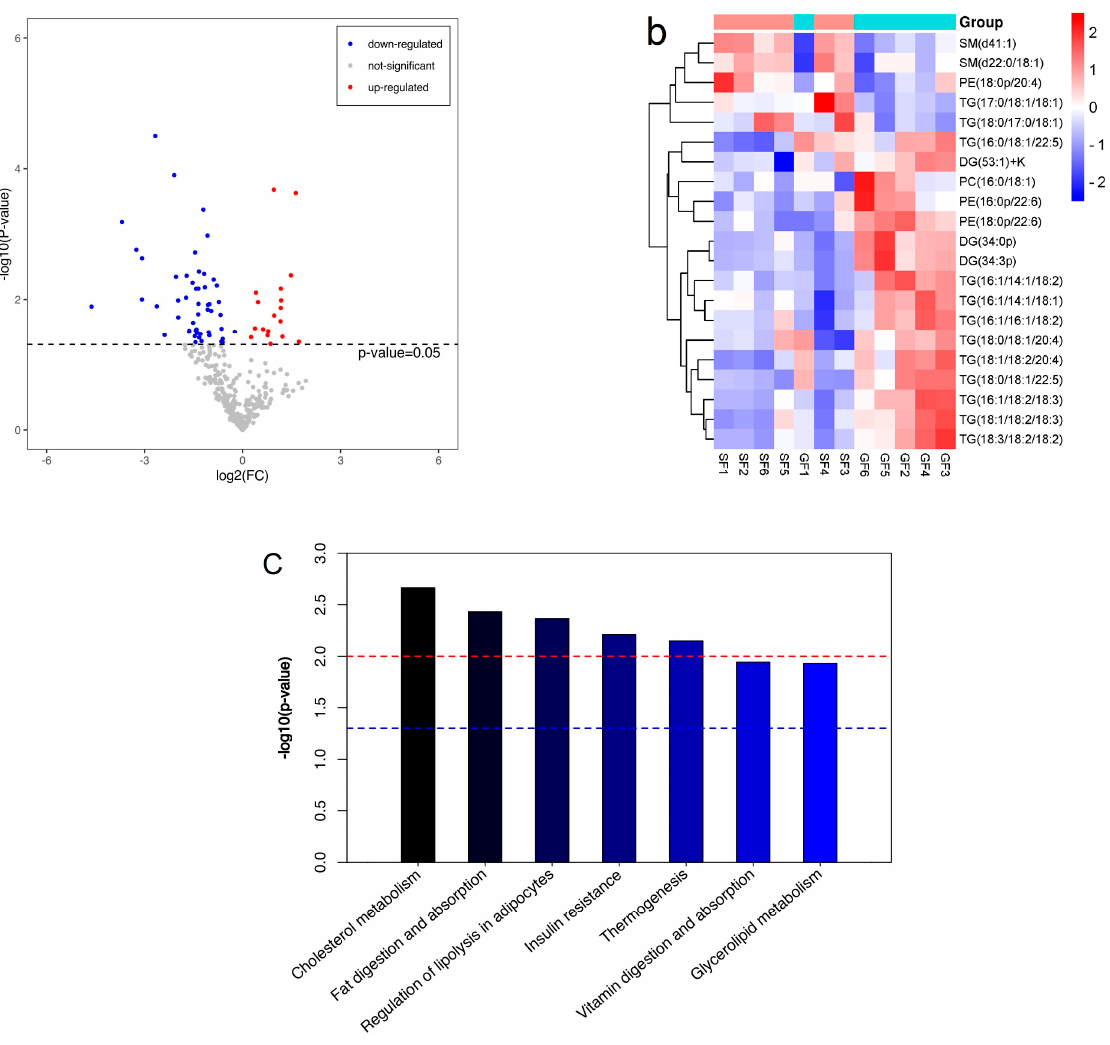
Figure 2. ( a ) The volcano plot of lipid abundance in the subcutaneous fat of SF yaks in contrast to GF yaks. The abscissa represents the value of log 2 fold change (FC), and the ordinate represents the value of − log 10 P . A point represents a gene. The points with FC > 2.0 and p < 0.05 or FC < 0.5 and p < 0.05 are shown in red or blue, respectively; non-di ff erent lipids (DLs) are shown in black. ( b ) The heat map of all DLs in the subcutaneous fat of SF and GF yaks. Each row represents a DL, and each column represents a sample. The color blocks at di ff erent positions represent the abundance of lipid molecules. Red represents high abundance in the subcutaneous fat of SF yaks, and blue represents low abundance in the subcutaneous fat of SF yaks. ( c ) The bar diagram of Kyoto encyclopedia of genes and genomes (KEGG) pathways for enrichment of DLs in the subcutaneous fat of SF and GF yaks.